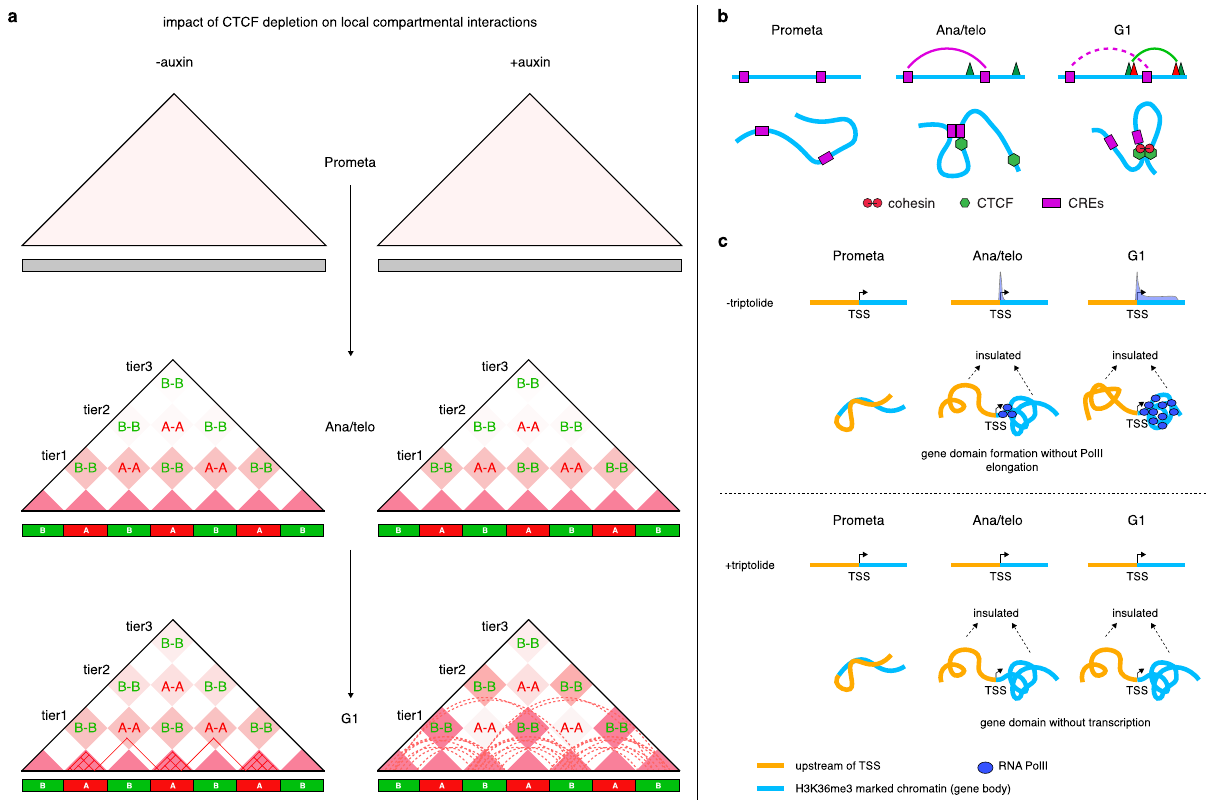
Fig. 6 Mechanistic models. a Schematic showing how CTCF removal can impact local but not distal interactions between the same type of compartments. Short-range B – B interactions were enhanced potentially due to increased extrusion loop size from A compartments after CTCF removal. Note, the effect was progressively observed in the G1 phase because of the gradual action of loop extrusion. Solid lines in the bottom panel represent structural loops formed and stabilized within A-type compartment domains in CTCF repleted conditions. Dotted lines represent actively extruding loops that are unleashed from A-type compartment domains into fl anking B-type compartment domains due to CTCF depletion. b Schematic showing the rapid dissolution of established CRE loops as nearby disruptive structural loops emerge after mitosis. c Schematic showing that a gene domain is already partially established prior to full coverage of the gene body by